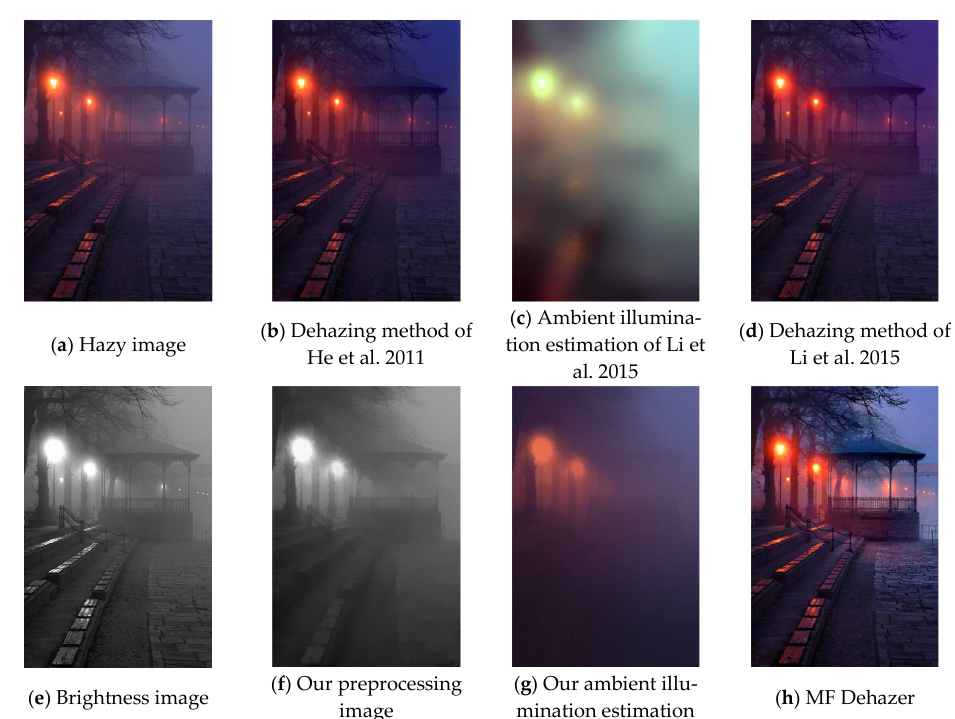
Figure 2. Comparison of ambient light estimation and dehazing by different methods. In order to ensure a fair comparison, we use the ambient illumination estimation methods of He et al. [9], Li et al. [26] and MF Dehazer and use the proposed transmission estimation method to remove haze to compare the effects of different ambient illumination estimation methods.